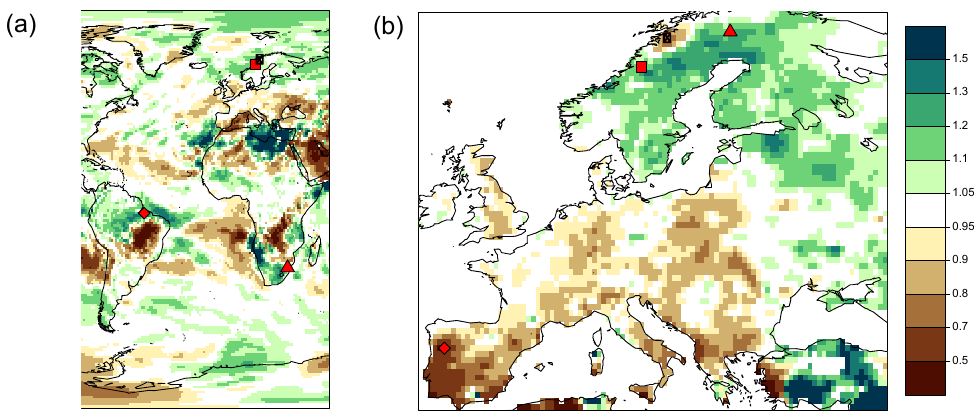
Figure 1. Maps of relative changes in boreal mean summer (JJA) precipitation, 1981–2005 relative to 1956–1980. (a) EC-EARTH, (b) E- OBS, version 15.0. Square: case 1 (true negative); circle: case 2 (false positive); triangle: case 3 (false negative); diamond: case 4 (true